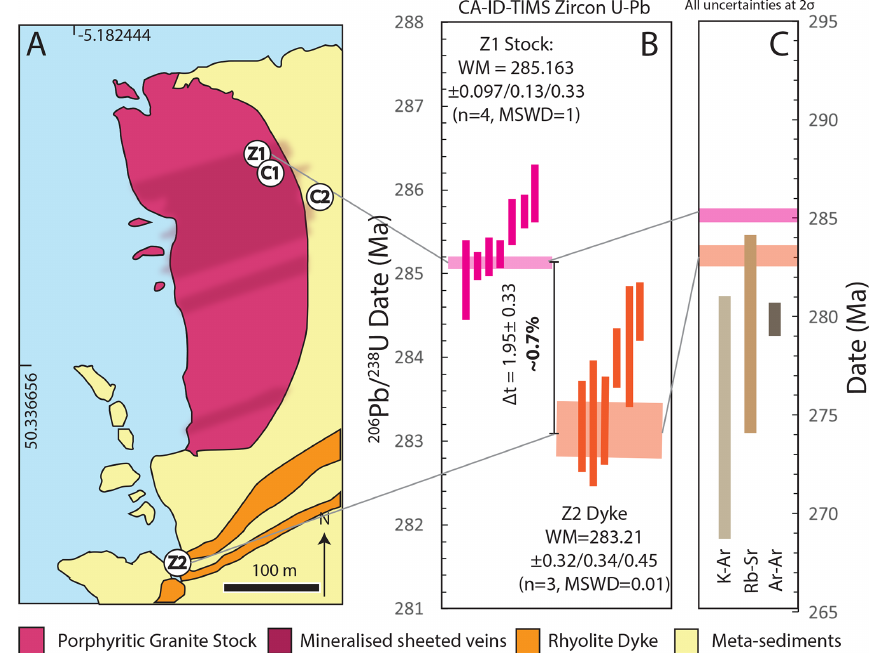
Figure 6. (a) Geological map of Cligga Head (after Moore and Jackson, 1977) with the localities of zircon samples (Z1 and Z2) and cassiterite samples (C1 and C2) marked; pale blue signifies sea level. (b) Zircon CA-ID-TIMS U–Pb dates and weighted-mean ages for Cligga Head magmatism of the porphyritic granite stock (Z1) and rhyolite porphyry dykes. Dark shaded boxes represent single analyses of zircon tips, and pale boxes represent weighted-mean dates. The intrusions define a period of ∼ 0.7% of the absolute age in which the cassiterite may have formed. Uncertainties are presented as ± x/y/z , where x represents analytical uncertainties only for comparison with cassiterite ID-TIMS U–Pb dates also using the ET535 tracer; y represents analytical and tracer calibration uncertainties; and z is the total uncertainty including the 238 U decay constant for comparison with ages derived from other decay systems. (c) Comparison of zircon CA- ID-TIMS U–Pb weighted-mean dates with previous geochronology for the greisen system (Chen et al., 1993; Halliday,